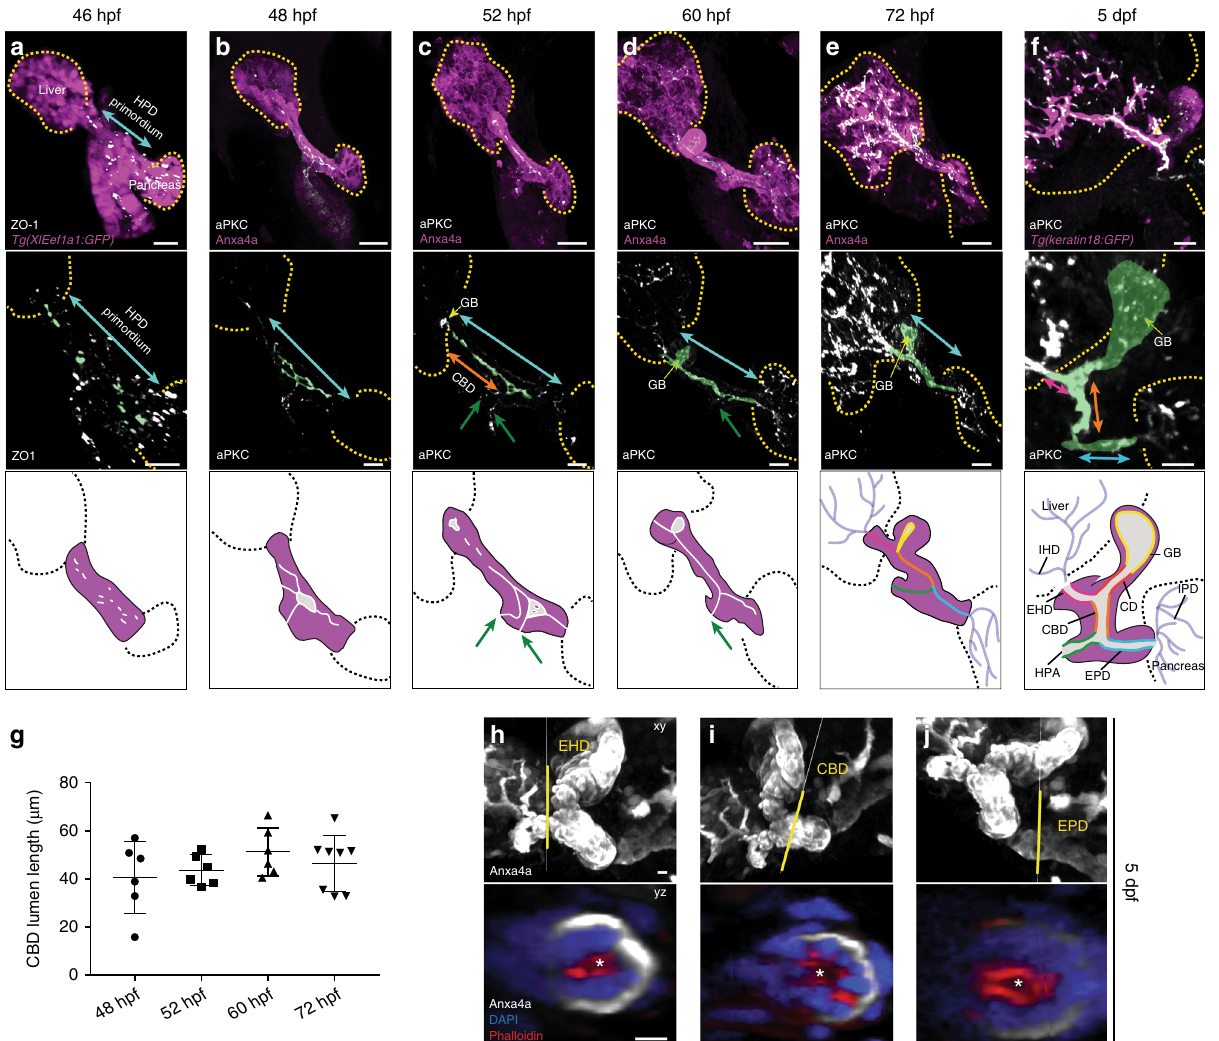
Fig. 1 The HPD system forms by de novo tubulogenesis. a The forming HPD is visualized by pan-endodermal Tg(Xla.Eef1a1:GFP) (magenta) and ZO-1 (gray) labels the fi rst junctional aggregates in the HPD primordium (blue arrow) at 46 hpf. b Ductal endoderm expression of Anxa4 (magenta) and apical aPKC (gray) visualize HPD morphology and nascent microlumina within the prospective CBD and EPD ( n = 17, N = 3). c The HPD system elongates and the gallbladder anlage (yellow arrow) becomes detectable at 52 hpf. The immature EHB and HPA lumina show gaps and luminal loops compared to the EPD exhibiting a continuous immature lumen ( n = 21, N = 3). The HPA connects at two points (green arrows). d At 60 hpf, all ductal compartments and a sphere-like gallbladder display a continuous emerging lumen, including a single connection of the HPA (green arrow), but excluding the EHD ( n = 29, N = 2). See also Supplementary Movie 1. e Along organ growth, the HPD tubes start bending from 72 hpf. The emerging lumen formed in the HPD system is continuous and connected to both IHD and IPD luminal network ( n = 11, N = 2) f transgenic keratin18:GFP expression visualizes the compact EHB and IHD at 5 dpf ( n = 13, N = 4), see also Supplementary Movie 8. Schematic overviews of HPD differentiation ( a – f ): starting with junctional aggregates and resulting in a continuous lumen spanning the HPD system. From 52 hpf individual HPD compartments are distinguishable: extrahepatic duct (EHD, pink); cystic duct (CD, red); gallbladder (GB, yellow); common bile duct (CBD, orange); extrapancreatic duct (EPD, blue); hepatopancreatic ampula (HPA, green). Scale bars: a – f = 10 μ m. g Lumen length quanti fi cation of the differentiating CBD between 48 and 72 hpf. h – j At 5 dpf, cortical actin indicates open lumina in the wild-type EHD, CBD and EPD; scale bars = 10 μ m. Magni fi ed cross-sections show open lumina (asterisk) of indicated ductal domains (yellow lines); scale bars = 5 μ m. Error bars show SEM; n = sample number, N = number of experiments. Source data are provided as a Source Data fi